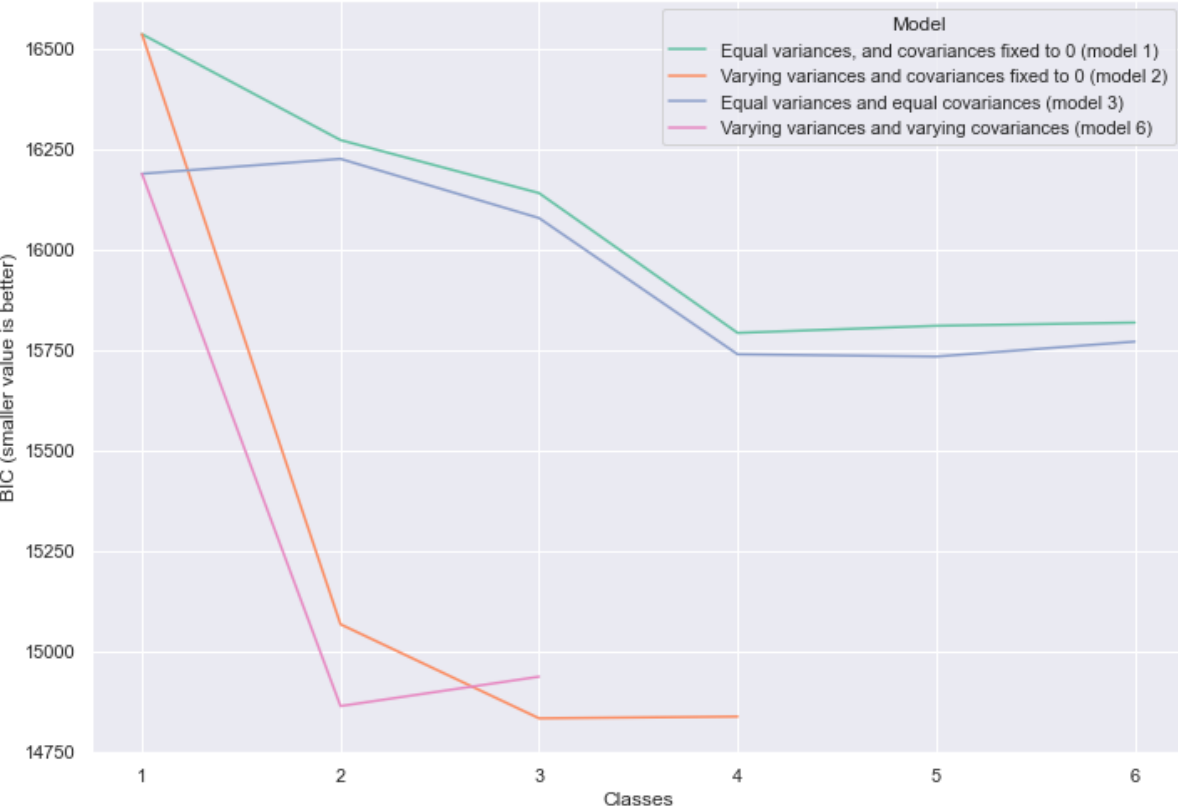
Figure 1. Comparison of different numbers of classes and models as measured by the Bayesian information criterion